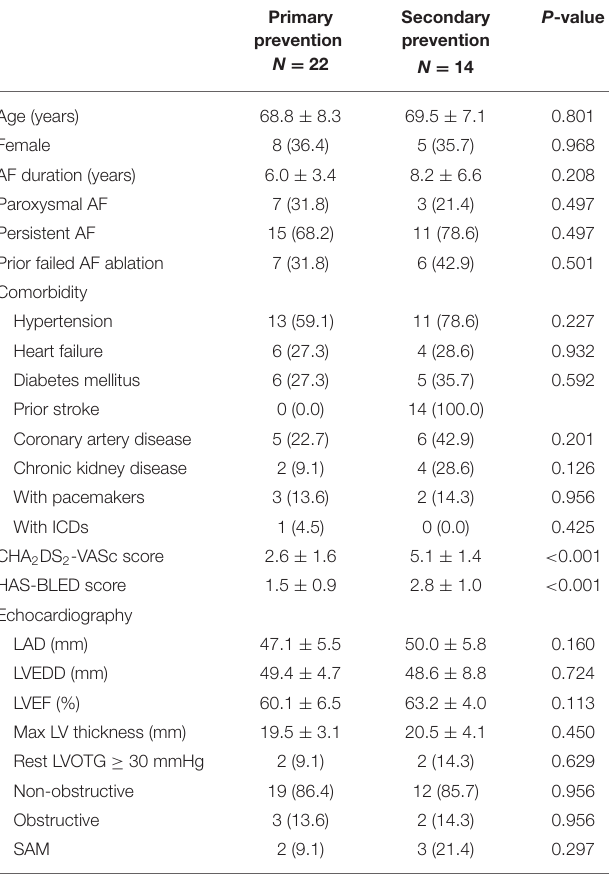
TABLE 1 | Baseline characteristics of patients with hypertrophic cardiomyopathy and atrial fibrillation.